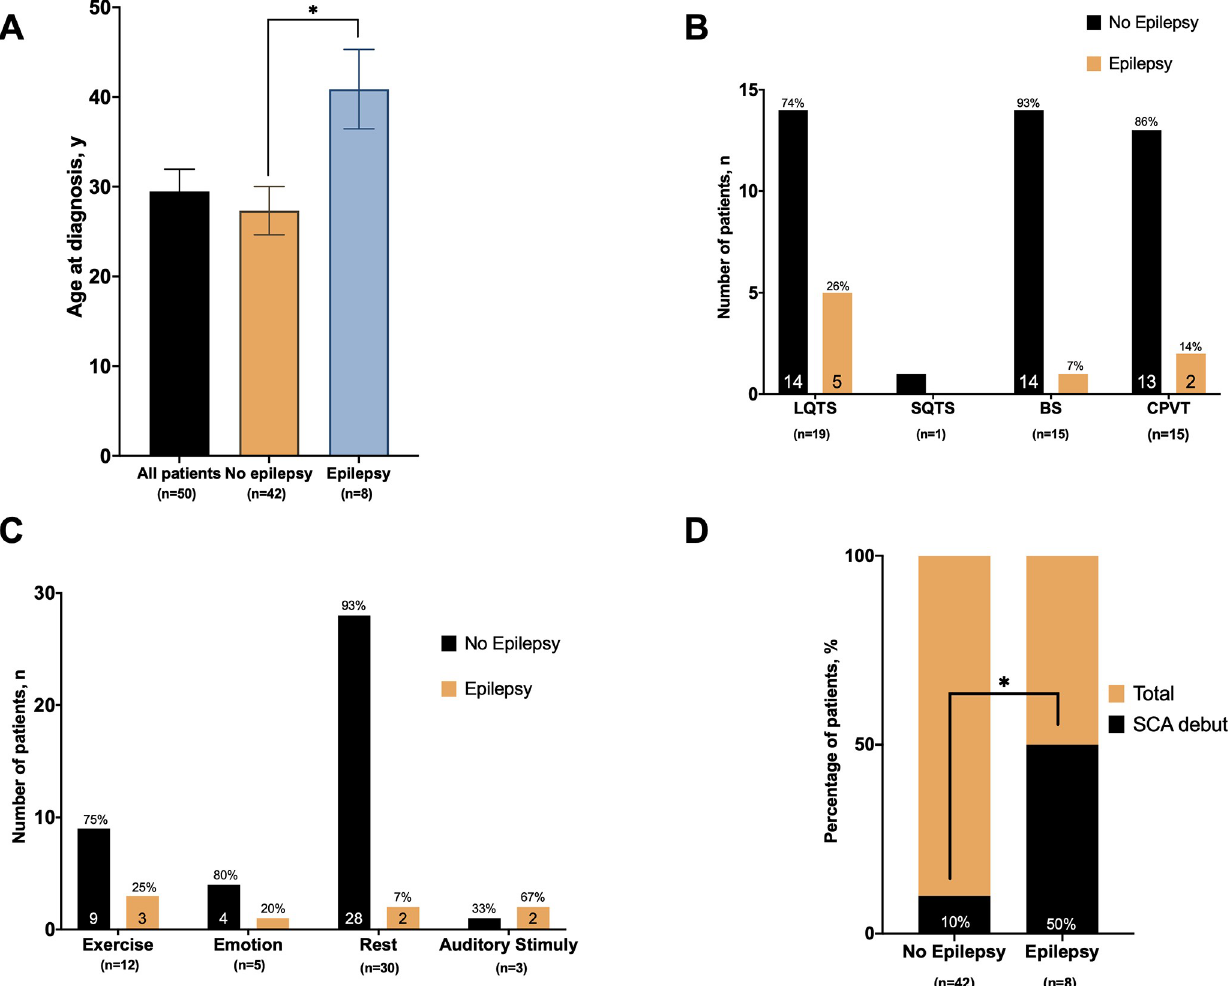
Fig 2. Age at diagnosis in years in the two different groups showing a significantly delayed diagnosis in the previously misdiagnosed patients (Panel A). Compared distribution of primary inherited arrhythmic syndromes among probands (Panel B). Distribution of typical triggers within probands (Panel C). Percentage of patients presented with sudden cardiac arrest at time of diagnosis (Panel D). � number above bars represent the percentage among the group. † � means significance p value <